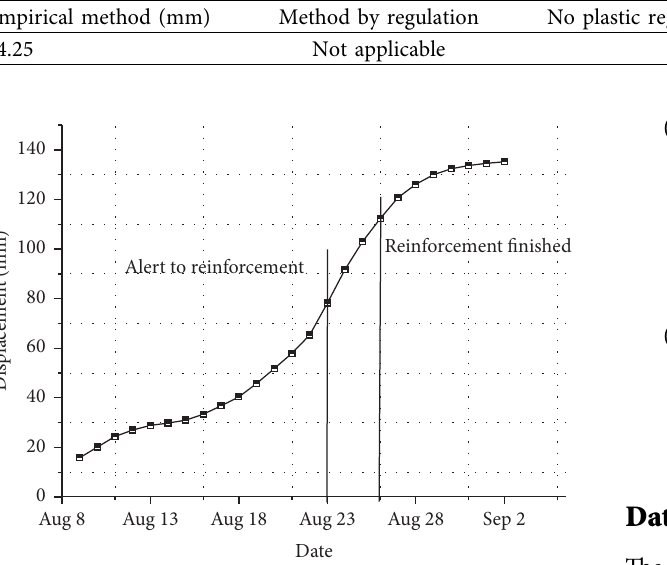
Figure 9: The curve between displacement and date at the 0+674.0